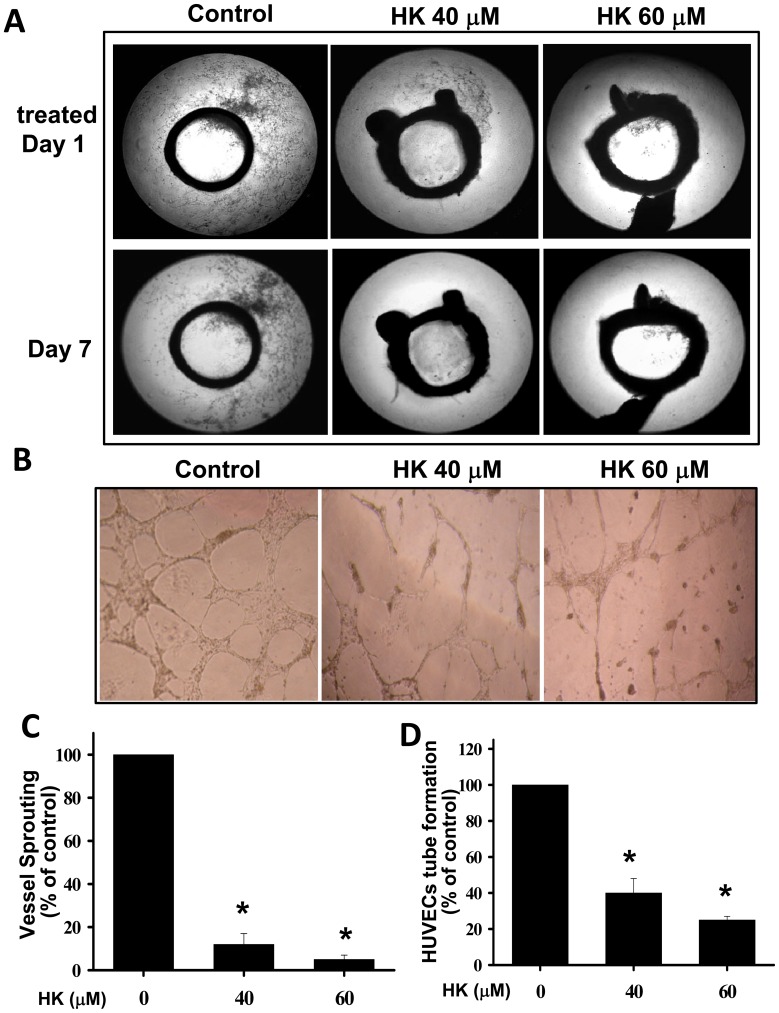
Effects of honokiol on endothelial cell sprouting and endothelial cell tube formation.(A) Honokiol inhibited endothelial cell sprouting in an aortic ring assay. Aortas were harvested from 6-week-old Sprague-Dawley rats and cut into 1-mm slices, which were then placed in 12-well plates containing matrigel. The rings were photographed and analyzed. The endothelial cell sprouting was abundant in the control aortic rings (left panels), but not in the rings treated with honokiol (HK; middle panels, 40 µM; right panels, 60 µM). (B) Honokiol suppressed the endothelial cell tube formation. HUVECs were seeded into matrigel-coated 96-well plates. Cells were treated with honokiol (40 and 60 µM) for 12–18 h. The tube formation images were captured in an inverted photomicroscope, and tube formations were scored. (C) The degree of microvessel sprouting from aortic rings was scored from 0 (least positive) to 4 (most positive). (D) Quantification of HUVEC tube formation is shown. All data are presented as mean ± SEM (n = 8–10). *p<0.05 as compared with control.